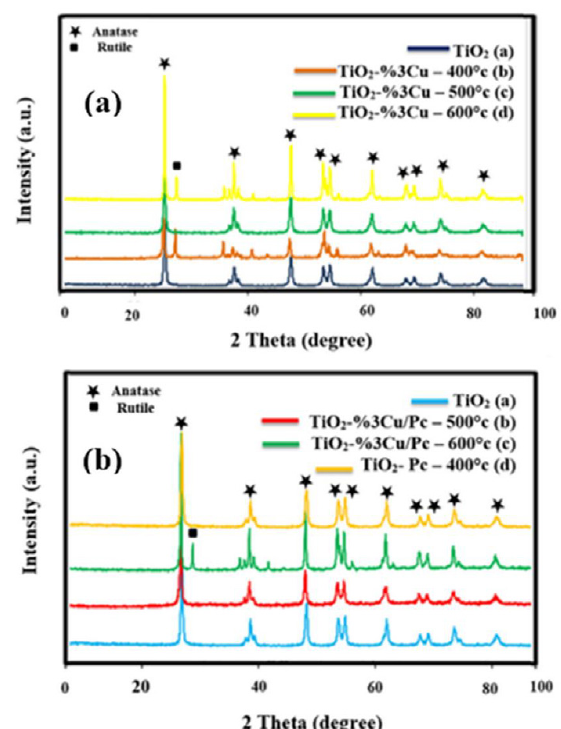
Fig. 1. X-ray diffraction patterns of: (a) Cu-TiO